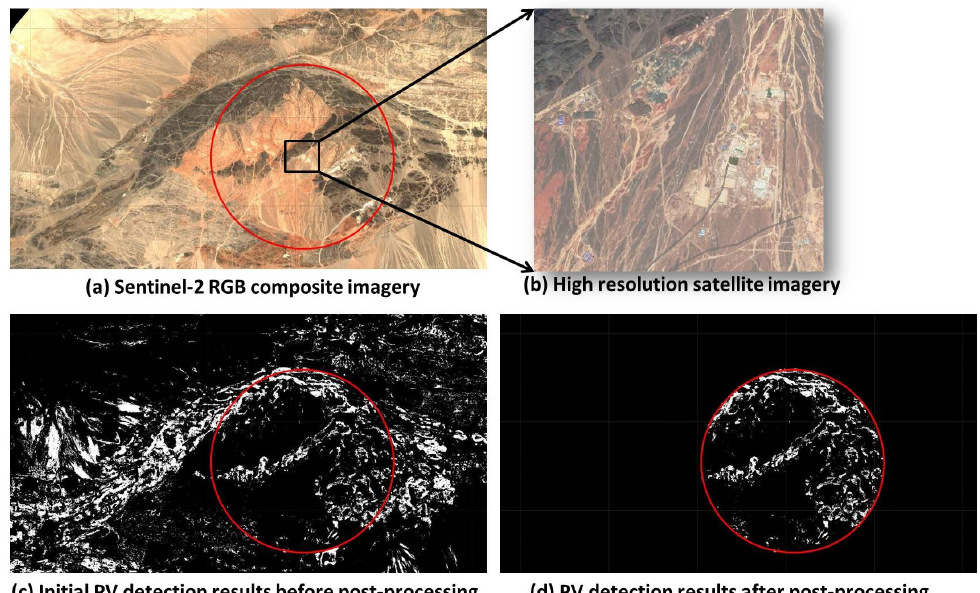
Figure 9. Bare rocks and mountain shadows misclassified as PV in Gansu Province (94.59°E, 40.90°N) ( a ) Sentinel-2 imagery, ( b ) manmade buildings in the center of the mask area, ( c ) the initial PV detection results before post-processing, ( d ) PV detected after post-processing.